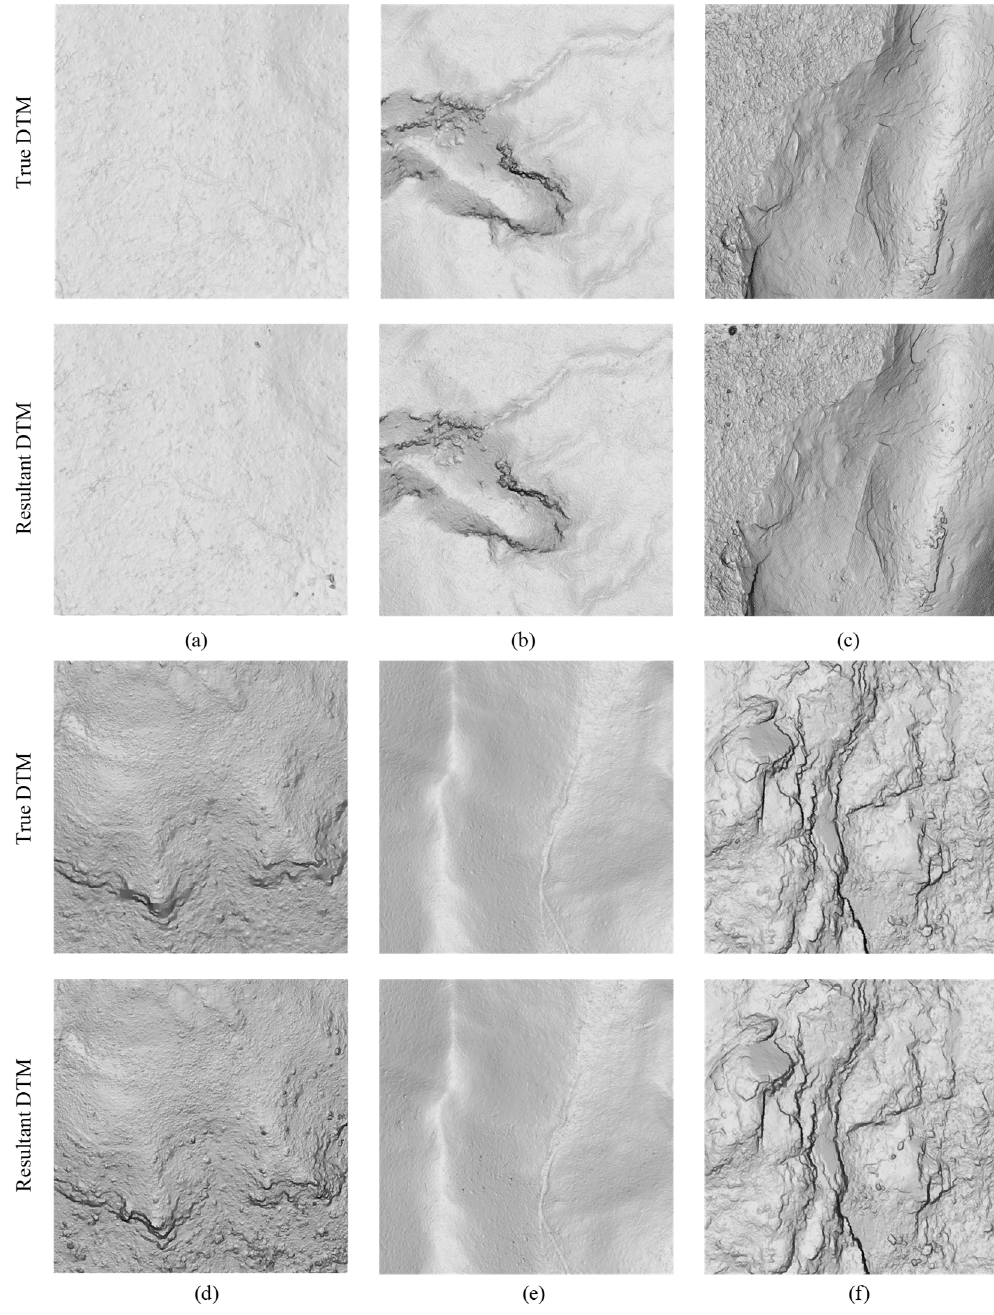
Figure 12. DTMs of the proposed method in all sites: ( a – f ) Sites 1–6.